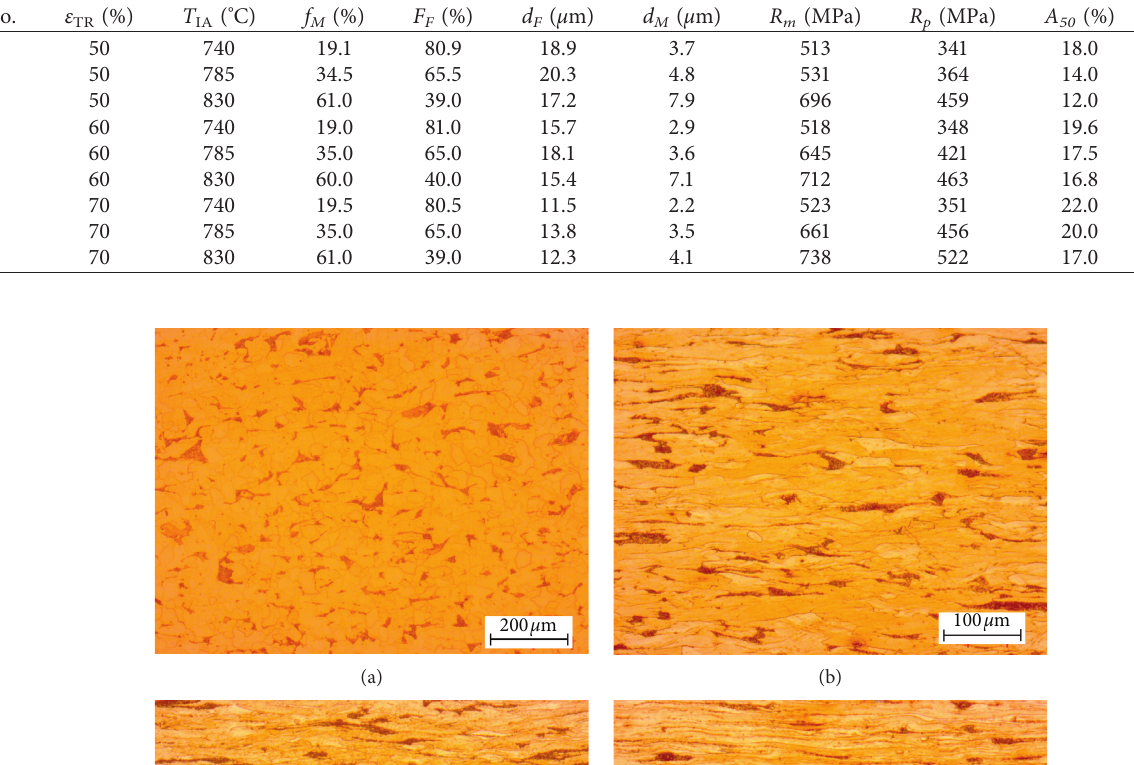
Table 3: Mechanical properties of the dual-phase treated steel.